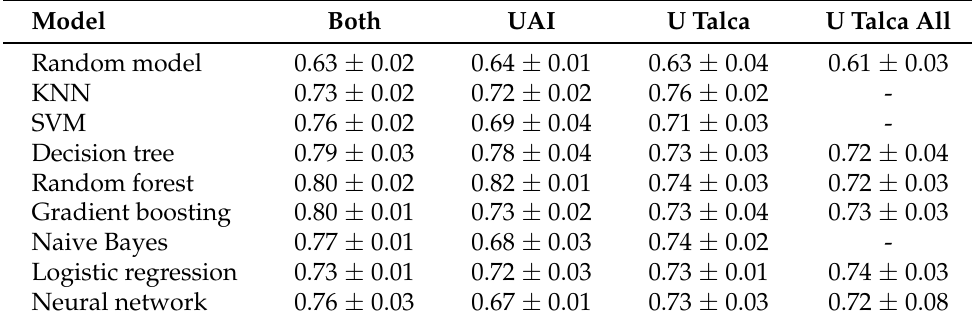
Table 3. F 1 score − class, for each